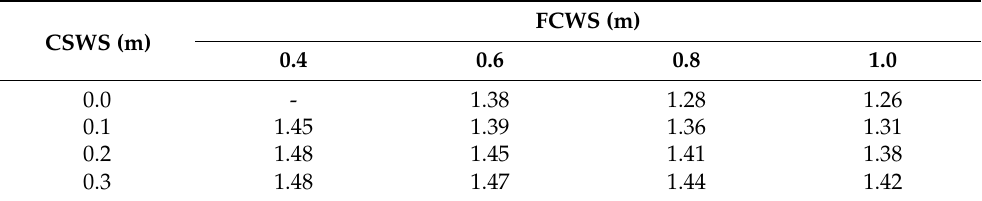
Table 6. The influence of different combinations of CSWS and FCWS on the tree height extraction accuracy ( RMSE /m) of C. equisetifolia detection.